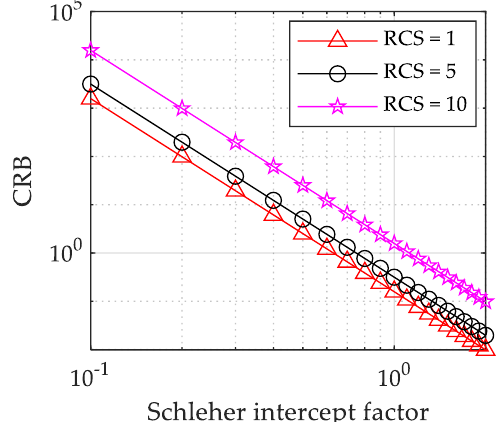
Figure 4. Relation curve between CRB and Schleher Interception Factor under different target RCS strengths (4 × 4 Radar